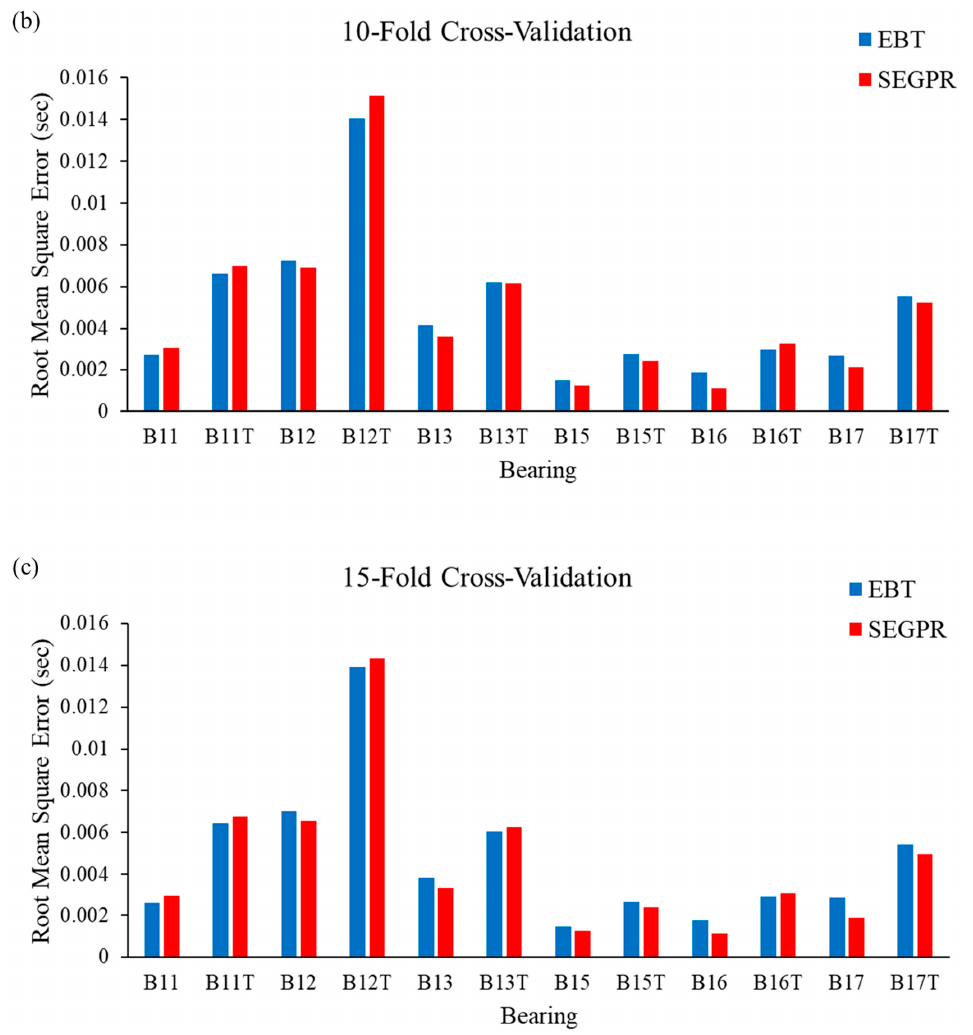
Figure 9. ( a – c ). RMSE values observed from the EBT and SEGPR ML models.